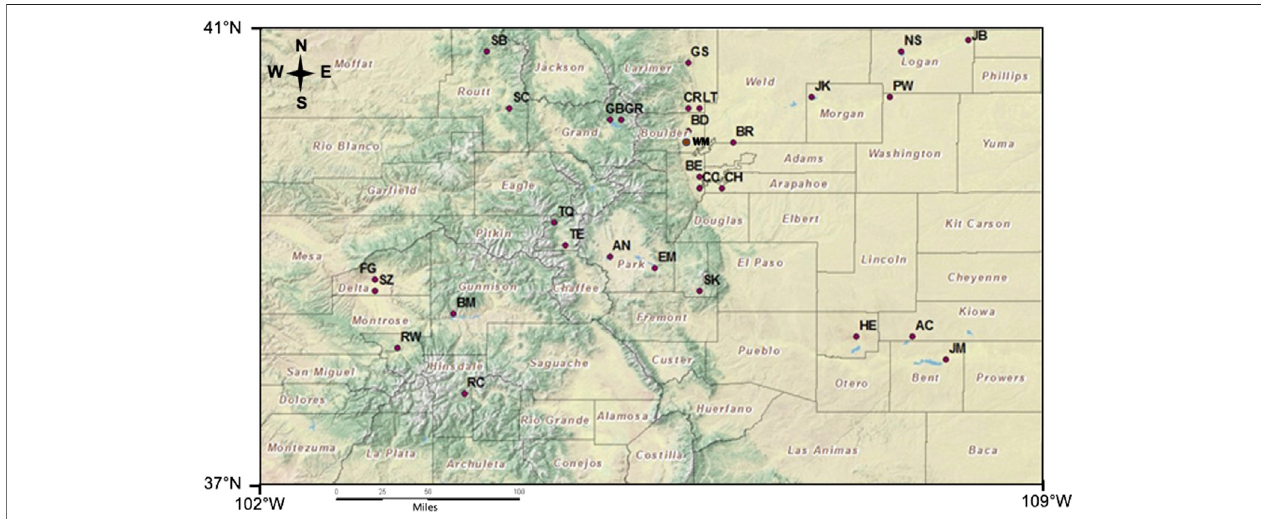
FIGURE 1 | Distribution of the 30 reservoirs sampled across the state of